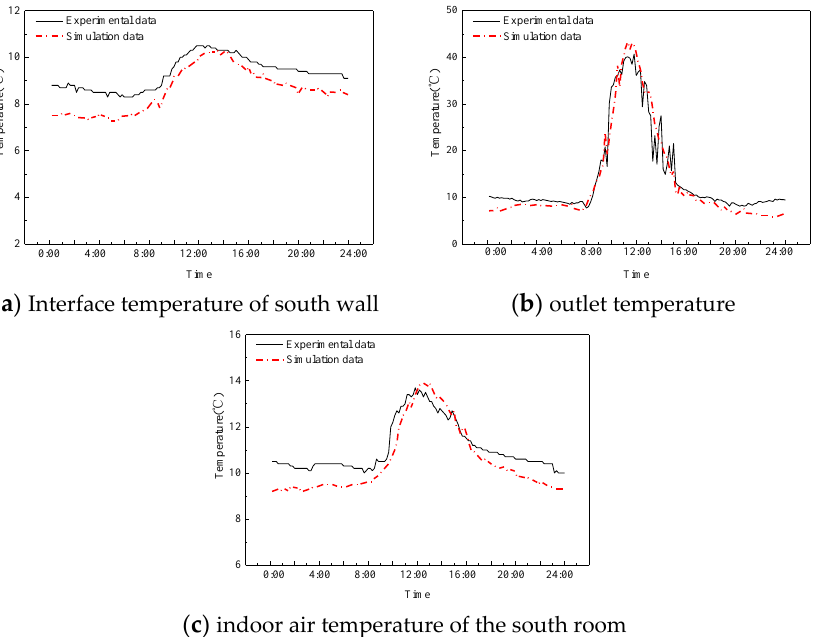
Figure 13. Validation of simulation results under passive heating.